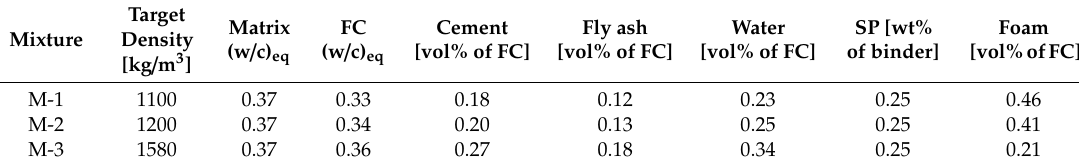
Table 5. Mixture compositions of the foam concretes under investigation. FC: foam concrete, SP: superplasticizer.